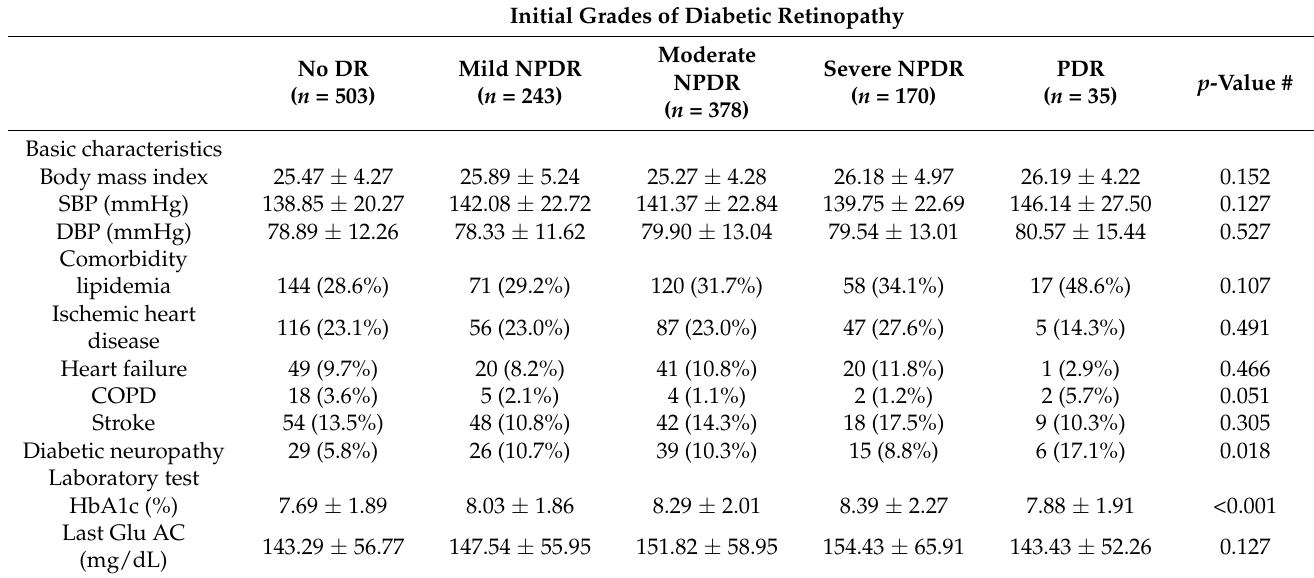
Table 2. The characteristics of patients with different initial grades of diabetic